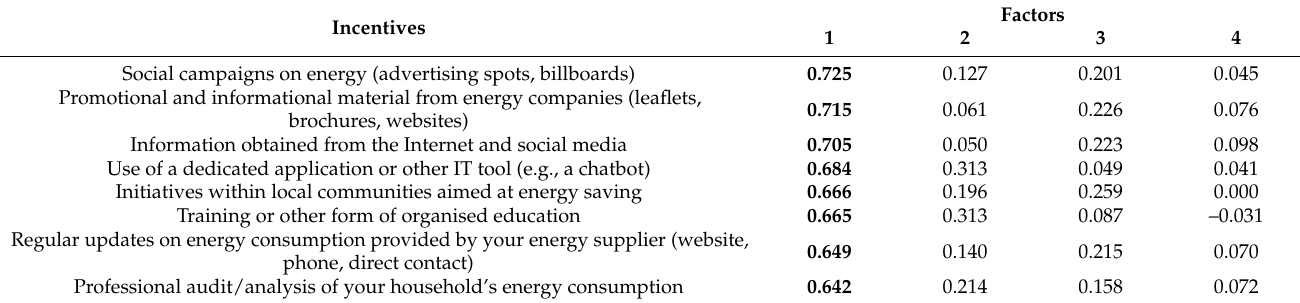
Table 2. Factor loading